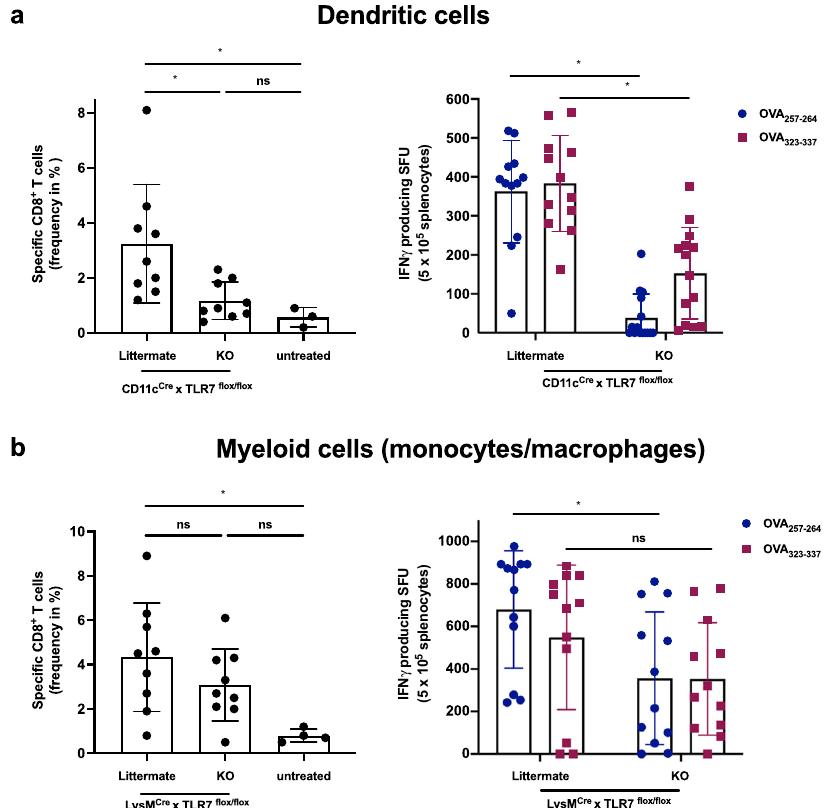
Fig. 4 DIVA-induced T cell activation requires TLR7 in DCs and partly in macrophages. Both CD11c Cre × TLR7 fl ox/ fl ox and LysM Cre × TLR7 fl ox/ fl ox (knock-out mice or respective littermates) were transcutaneously immunized as depicted in Fig. 2a. On day 35, the frequency of OVA 257 – 264 speci fi c CD8 + T cells was assessed in the blood of a CD11c Cre × TLR7 fl ox/ fl ox or b LysM Cre × TLR7 fl ox/ fl ox and the respective littermates ( fl ow cytometry gating in Supplementary Fig. 1a). On day 36, splenocytes of a CD11c Cre × TLR7 fl ox/ fl ox or b LysM Cre × TLR7 fl ox/ fl ox and the respective littermate were ex vivo restimulated with either OVA 257 – 264 or OVA 323 – 337 peptide and IFN- γ -producing cells were analyzed by ELISpot assays. Bars represent mean and SD of data collected from at least two independent experiments. *Signi fi cant difference with p < 0.05 by one-way ANOVA with Bonferroni ’ s